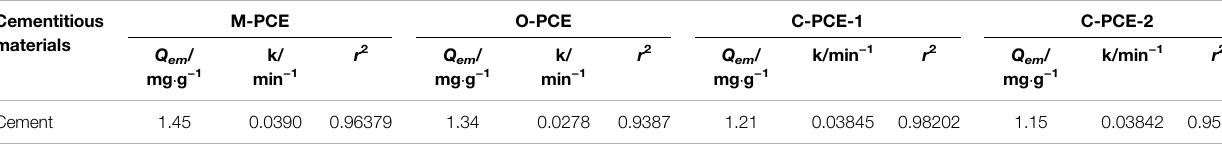
TABLE 5 | Fitted values of Lageren adsorption rate equation derived from polycarboxylate at 20 ° C. Cementitious M-PCE materials